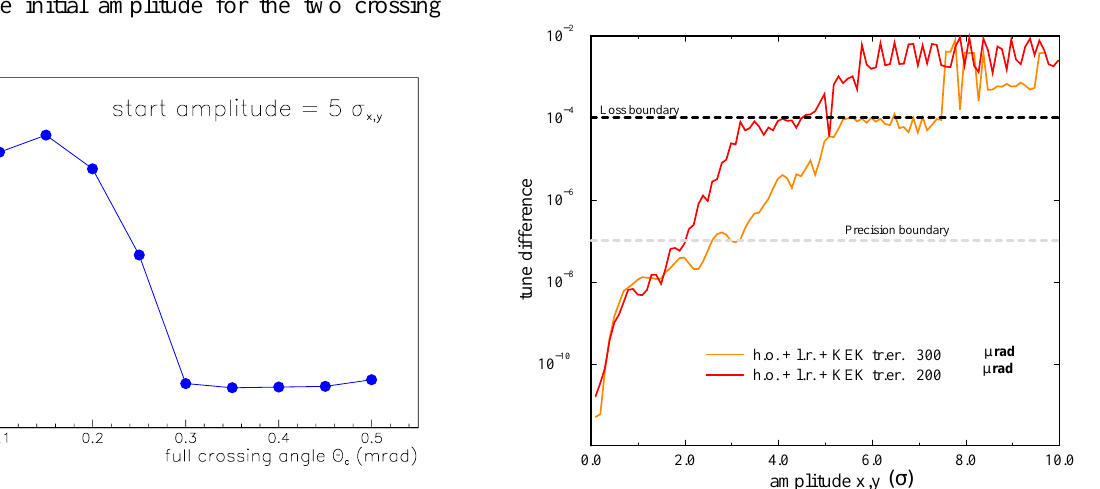
FIG. 15. (Color) The change of action variance per turn as a function of the full crossing angle. The start amplitude is 5 s x , y in both planes. The vertical axis gives the variance in units of the design rms emittance times 10 2 8 .